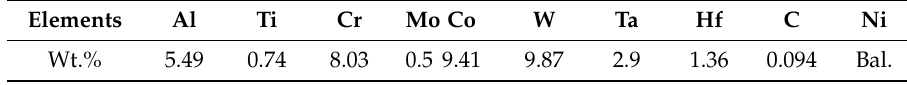
Table 2. The chemical composition of superalloy MM247LC (wt. %).